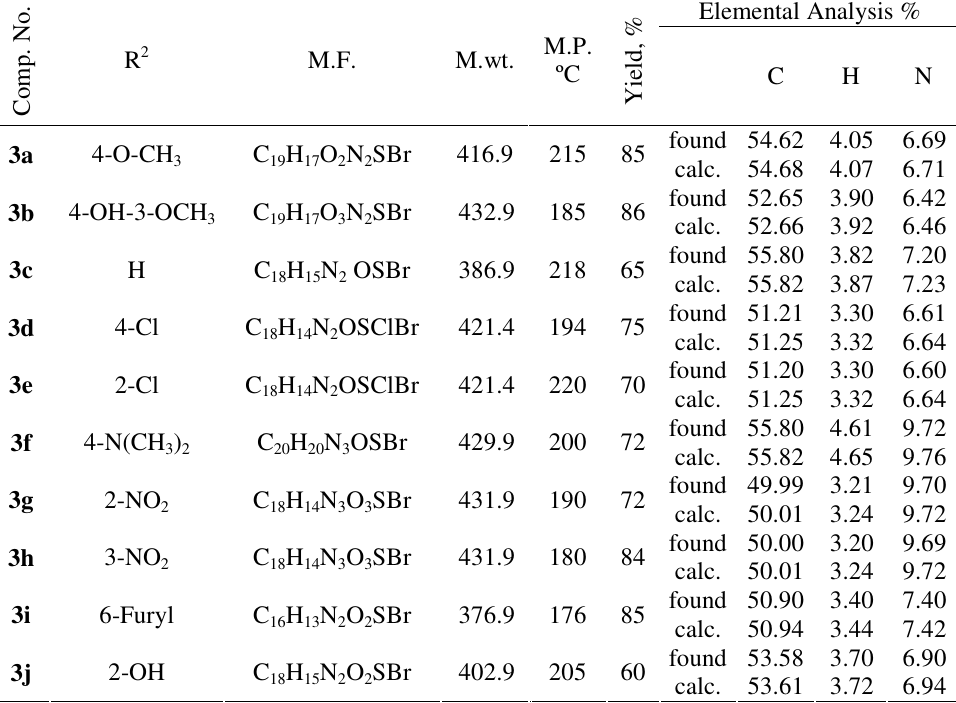
Table 1. Physical data of compounds